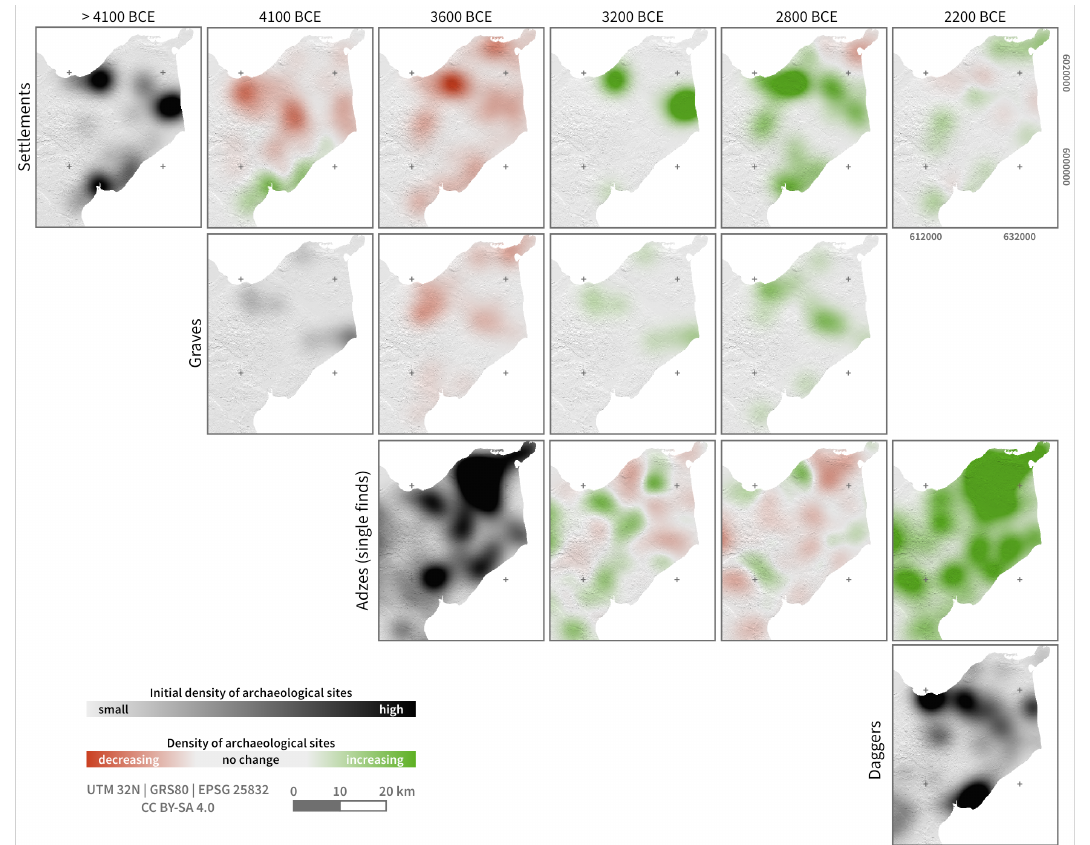
Figure 6. Differences in the absolute location of archaological sites throughout transformation periods (Rows indicate the different archaeological sources and context; columns correspond to the different Neolithic phases whose starting dates are shown. The utilized archaeological sample corresponds to all finds that belong to the different